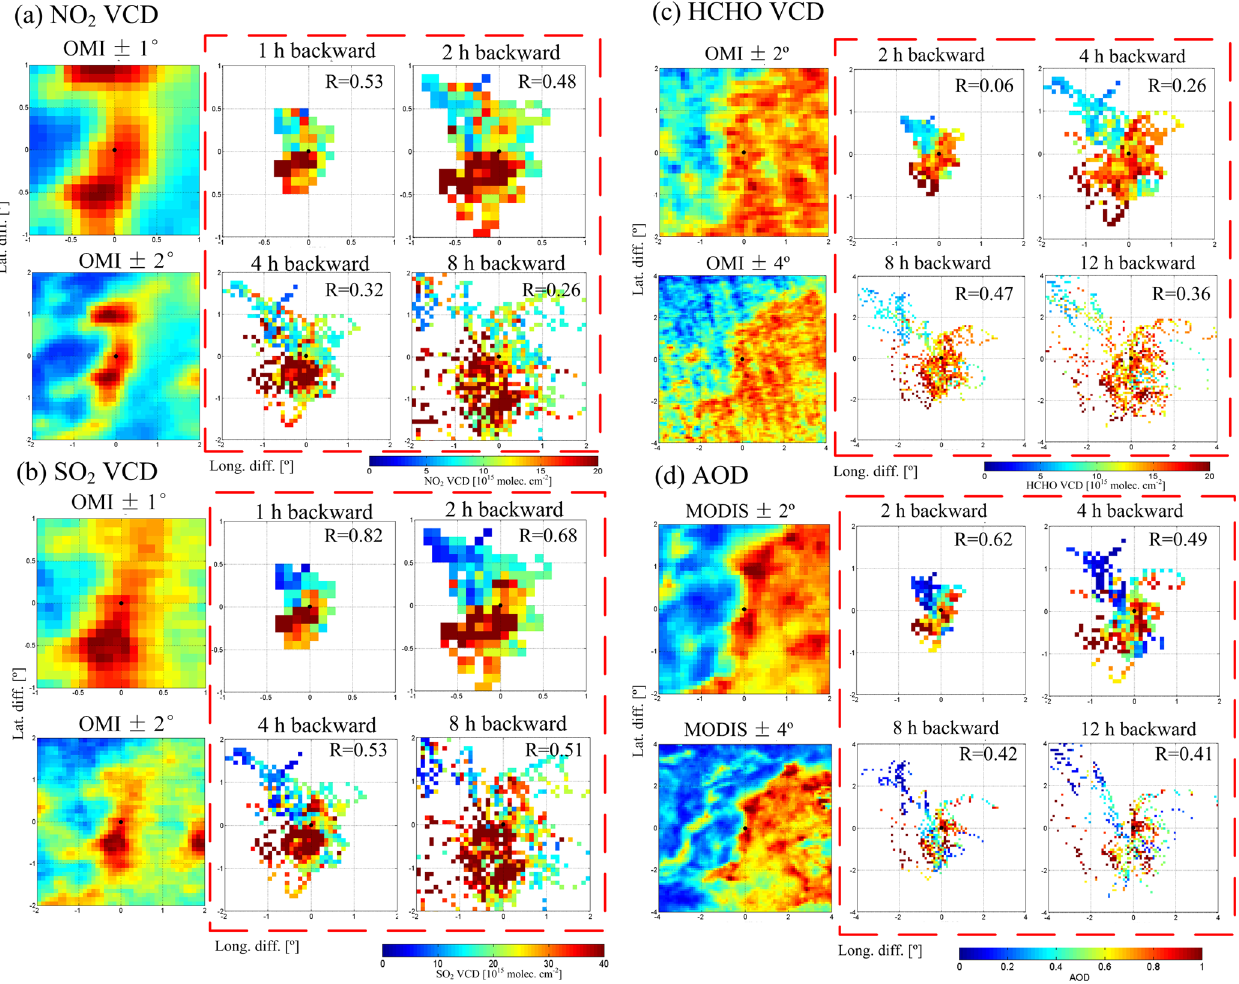
Figure 11. Average reproduced maps (inside the red dashed square) of column densities of NO 2 (a) , SO 2 (b) , HCHO (c) and AOD (d) based on MAX-DOAS measurements and back trajectories with different backward times (for details see text), and comparison with maps of the pollutants derived from OMI and MODIS satellite observations. Different times of the backward trajectories are used for the generation of the maps. The correlation coefficients of the pollutants in the reproduced maps against the satellite map are given in individual subfigures. Note that 1 ◦ latitude and longitude is about